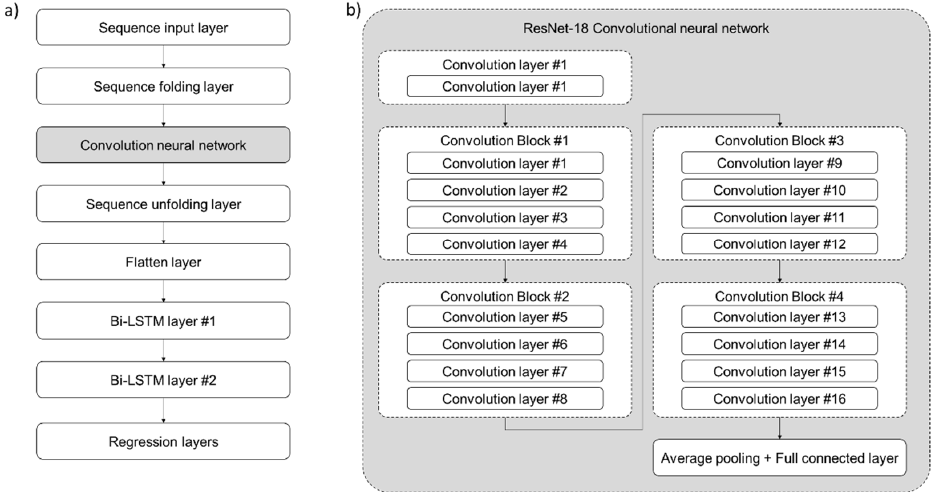
Figure 9. ( a ) The architecture of stacked CNN-LSTM deep learning model; ( b ) ResNet-18 CNN architecture